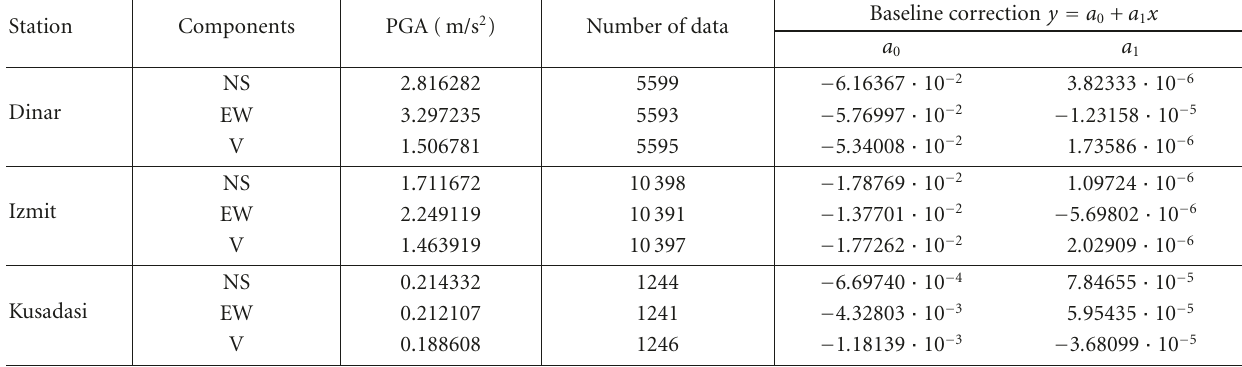
Table 2: Parameters of uncorrected acceleration records and baseline correction coe ffi